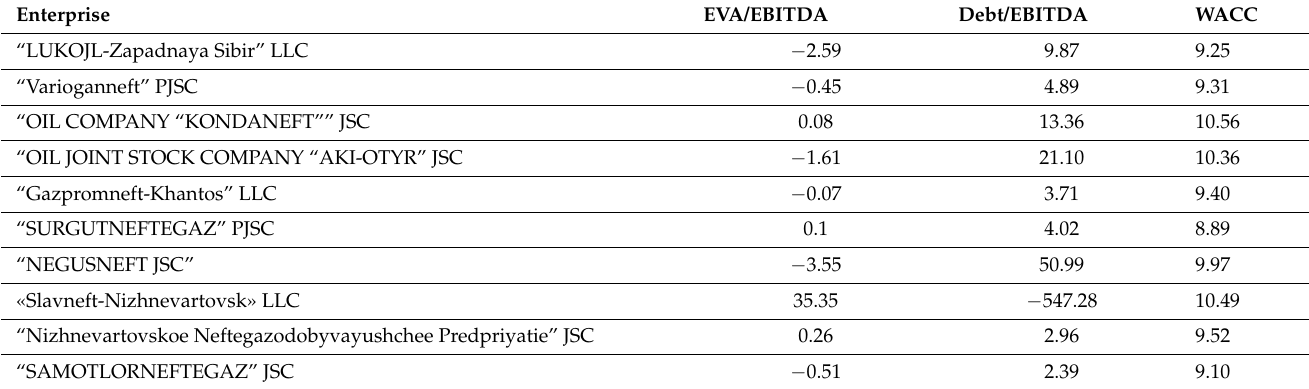
Table 4. Indicators for modeling the positioning diagram of extractive industry